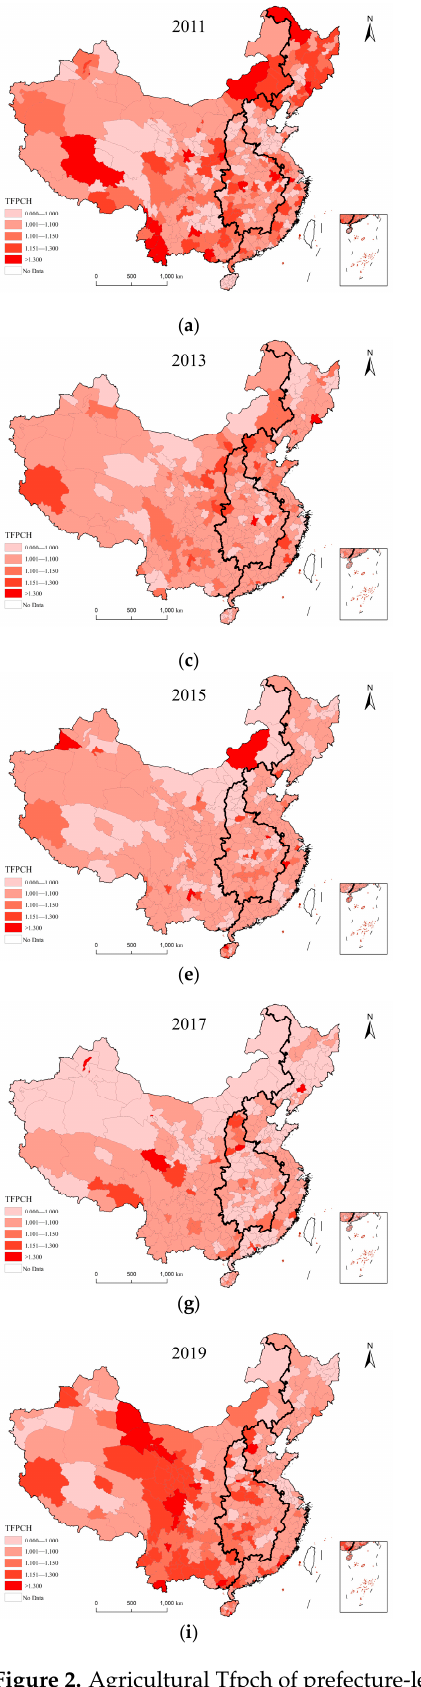
Figure 2. Agricultural Tfpch of prefecture-level cities in 2011 ( a ), 2012 ( b ), 2013 ( c ), 2014 ( d ), 2015 ( e ), 2016 ( f ), 2017 ( g ), 2018 ( h ), 2019 ( i ) and 2020 ( j